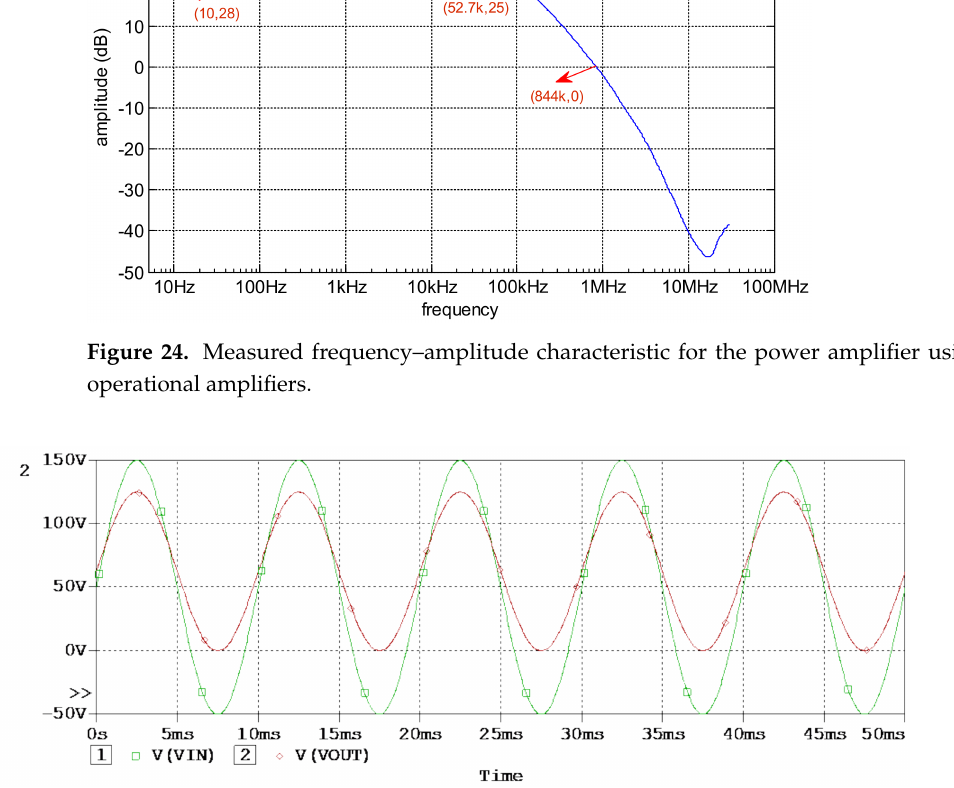
Figure 25. Simulated waveforms for the power amplifier using general operational amplifiers.